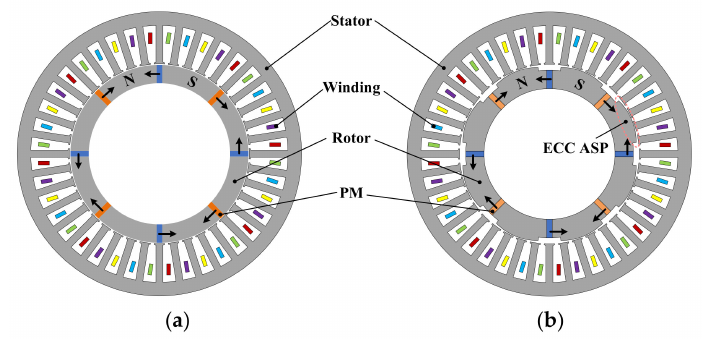
Figure 1. Rotor unit of the spoke PM motors. ( a ) Traditional rotor. ( b ) Rotor with ECC ASP.